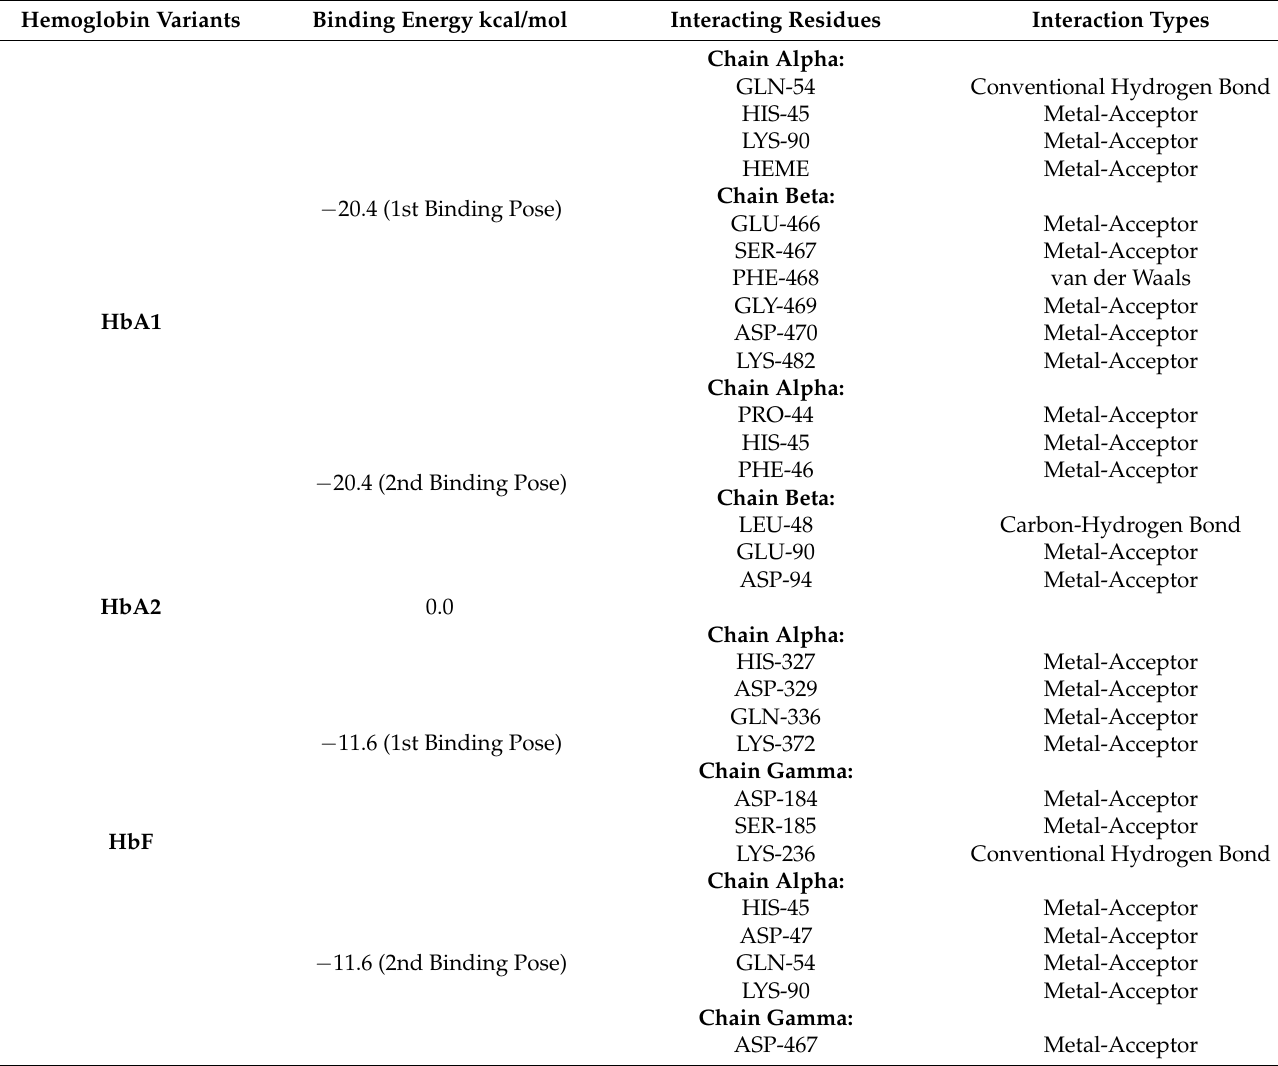
Table 1. Molecular docking results of different hemoglobin